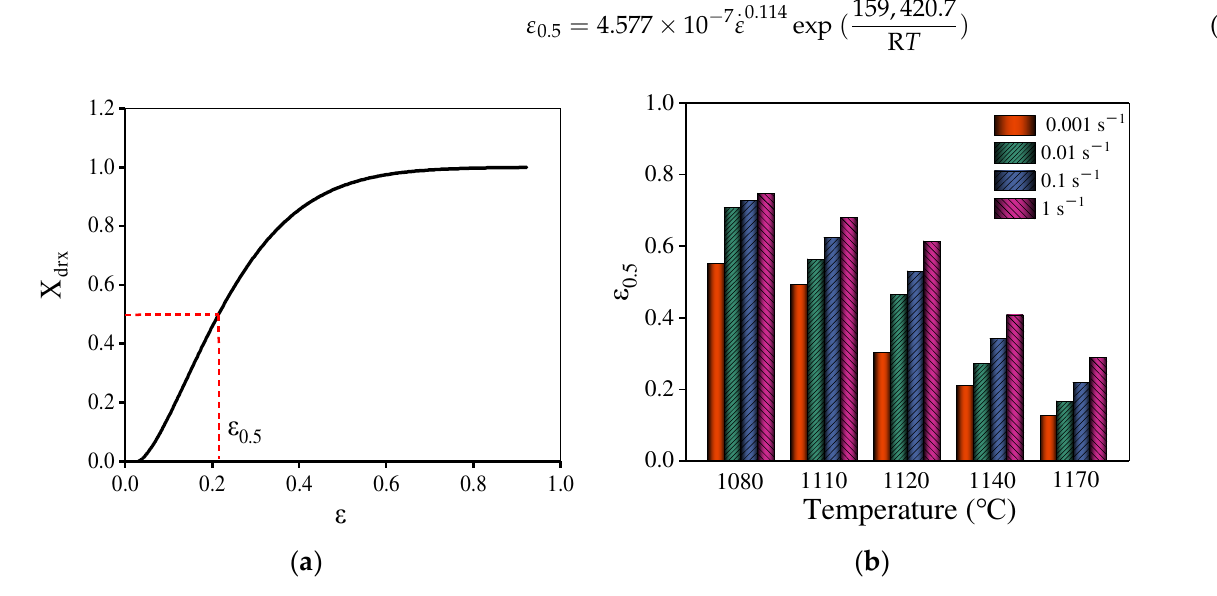
Figure 10. ( a ) Relationship between X drx and ε at 1140 ◦ C/0.001 s − 1 . ( b ) ε 0.5 at different deformation conditions.